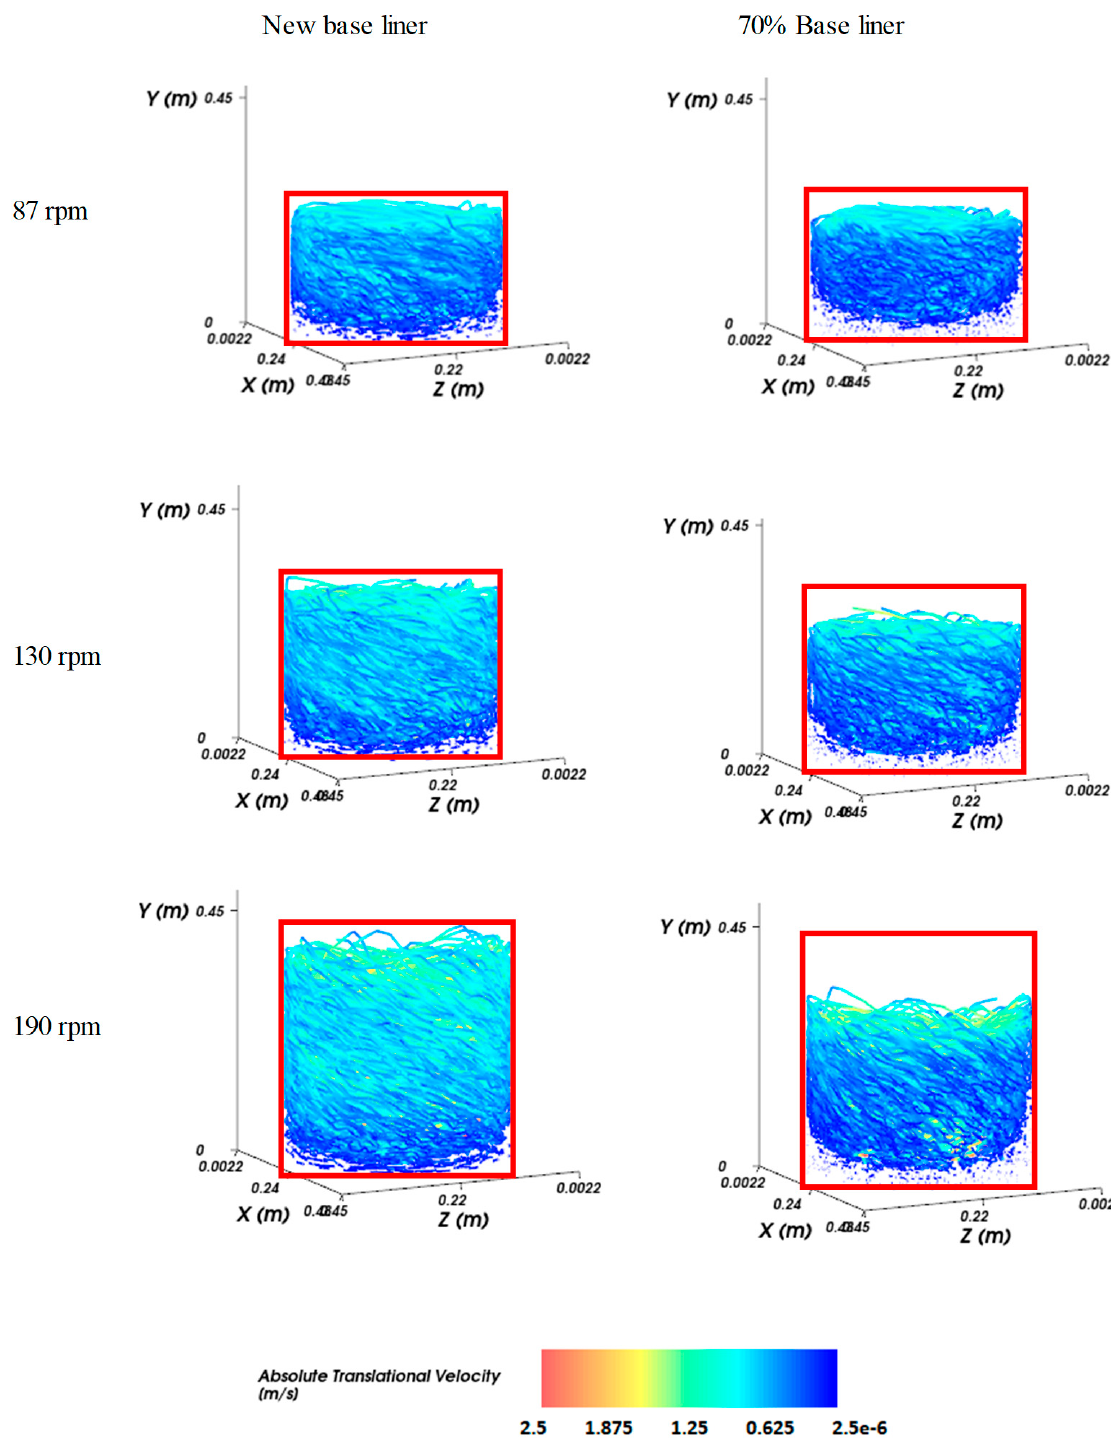
Figure 14. Particle trajectory and absolute translational velocity for new (left) and worn liner (right) conditions, at different mill velocities.